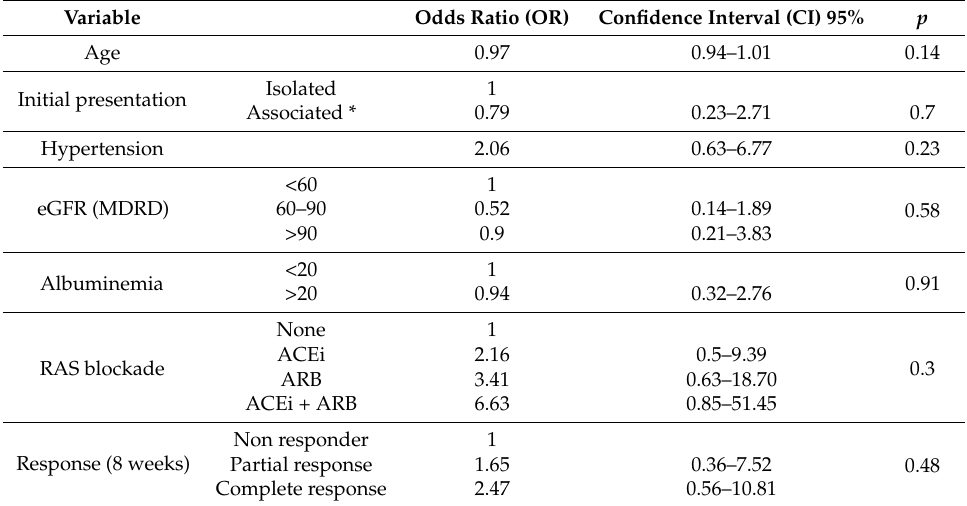
Table 4. Multivariate analysis for relapse according to initial presentation in MCD.